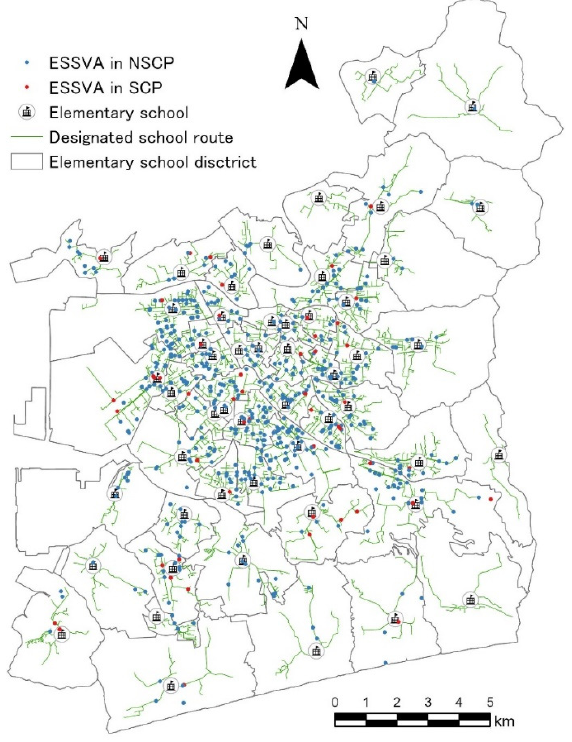
Figure 1. Locations of ESSVAs and designated school routes in the target area.